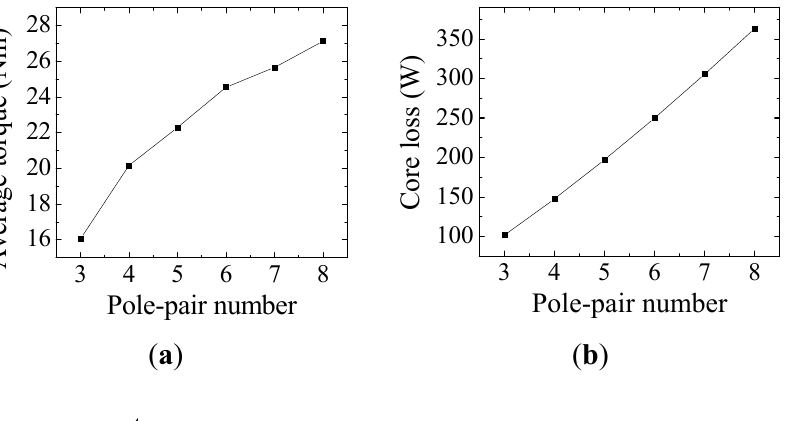
Figure 5. Variation of BDRM’s performance versus the pole-pair number: ( a ) average torque; ( b ) core